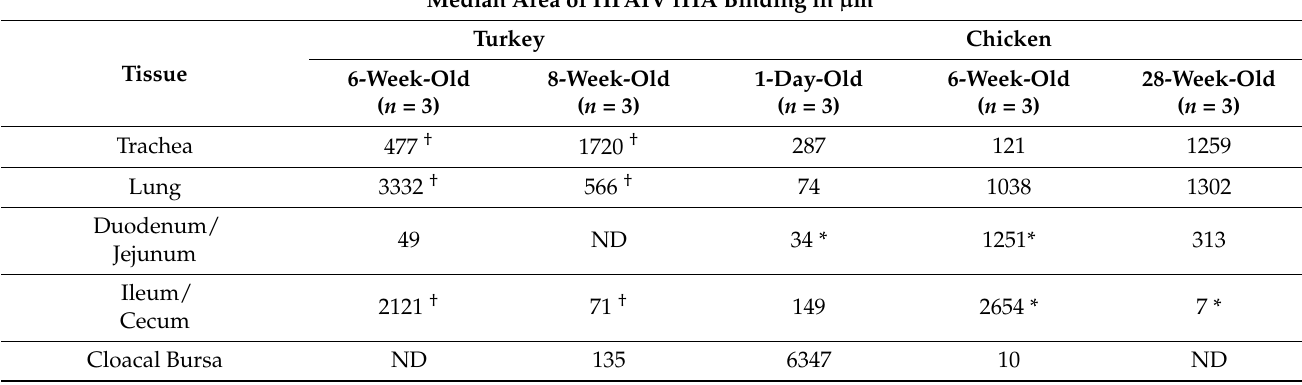
Table 2. Median area of binding (MAB) in µ m 2 of HPAIV rHA binding in the trachea, lung, small intestine, large intestine and cloacal bursa of turkeys and chickens of different age